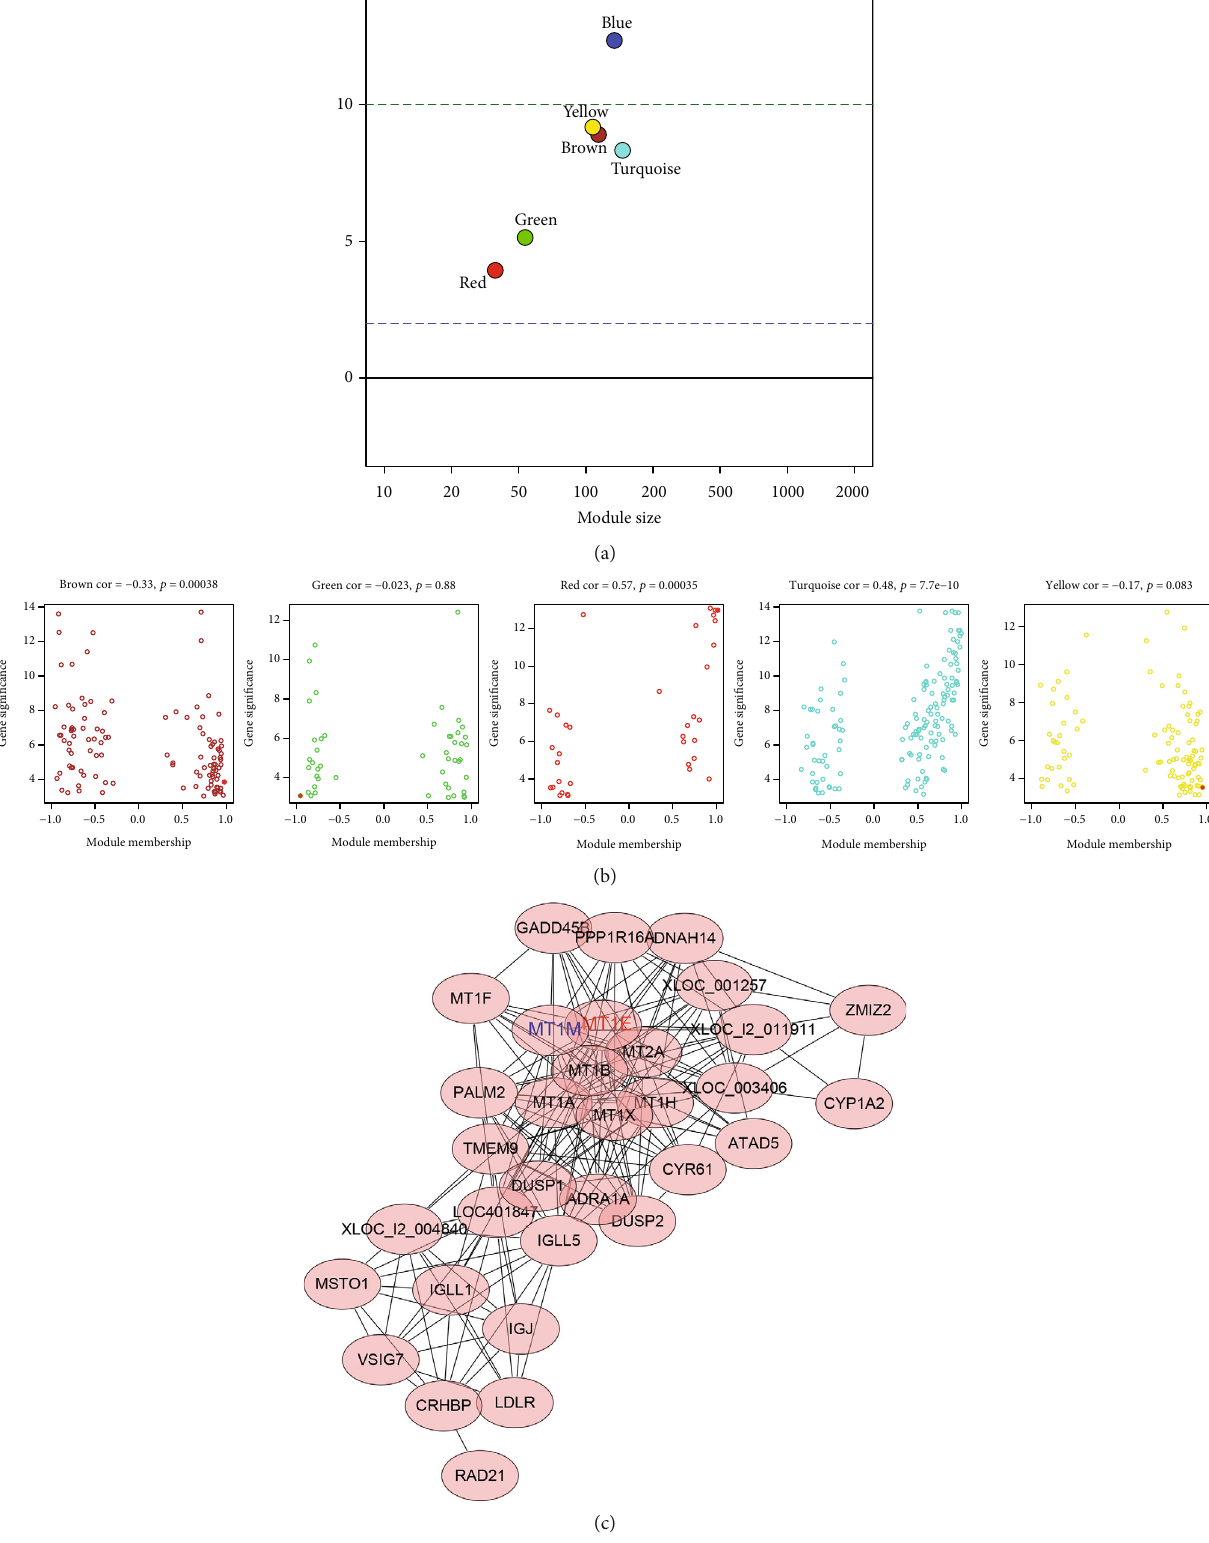
Figure 4: The Zsummary statistics of the module preservation and hub gene screening. (a) Zsummary score analysis of di ff erent modules. The dashed blue and green lines suggested the thresholds of 2 and 10, respectively. A Zsummary value between 2 and 10 indicates moderate module preservation, whereas a Zsummary > 10 provides strong support for module preservation. (b) Hub genes in di ff erent modules. The red solid points present the hub genes in each module. (c) Network of genes in the red